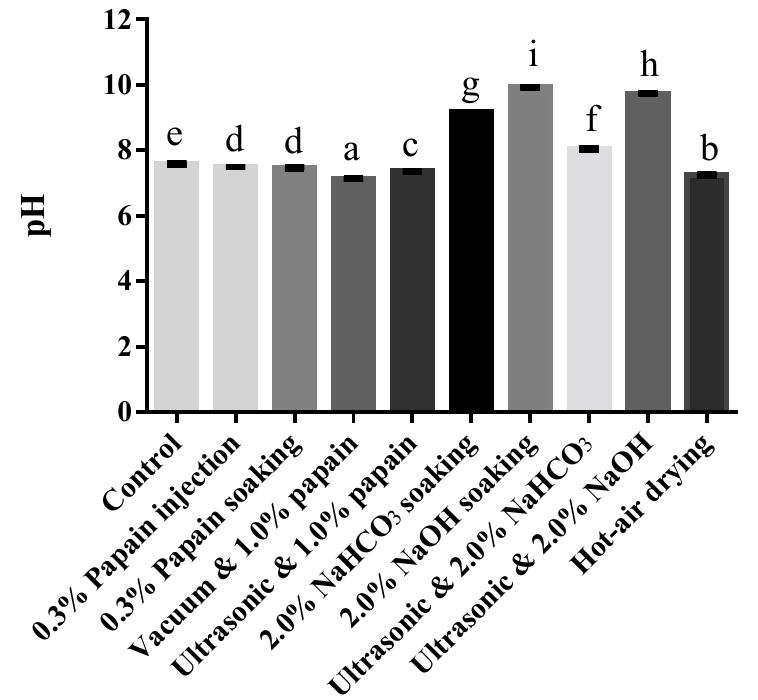
Figure 1. pH of neritic squid muscle treated with di ff erent softening methods, versus untreated